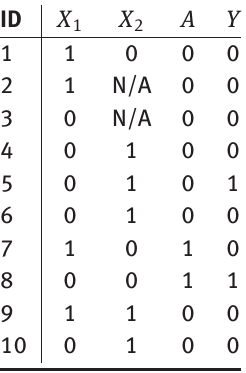
Table A1: Pre-imputed data. Observation 2 and observation 3 are both missing values for X 2 . ID X 1 X 2 A